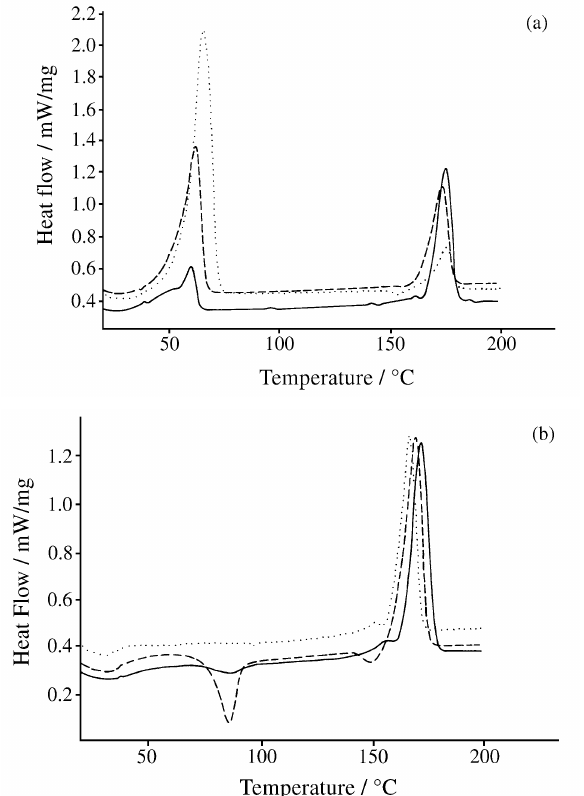
Figure 3. (a) Differential scanning calorimetry curves of (–) 80/20, (- - -) 50/50 and (. . . .) 20/80 PLLA/PEO blends (t = 0). Second heating. (b) Differential scanning calorimetry curves of (–) 80/20, (- - -) 50/50 and (. . . .) 20/80 PLLA/PEO blends (t = 7 days). Second